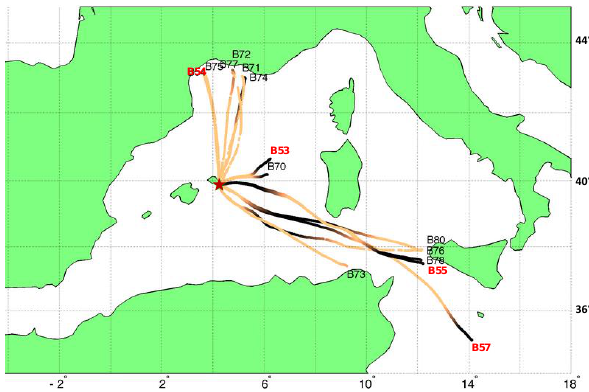
Figure 4. Trajectories of the 14 BPCL drifting balloons launched from Minorca during the campaign. Dark portions along trajectories correspond to night-time conditions. The four red labels from B54 to B57 indicate balloons with an ozone sonde and the 10 others carried a LOAC